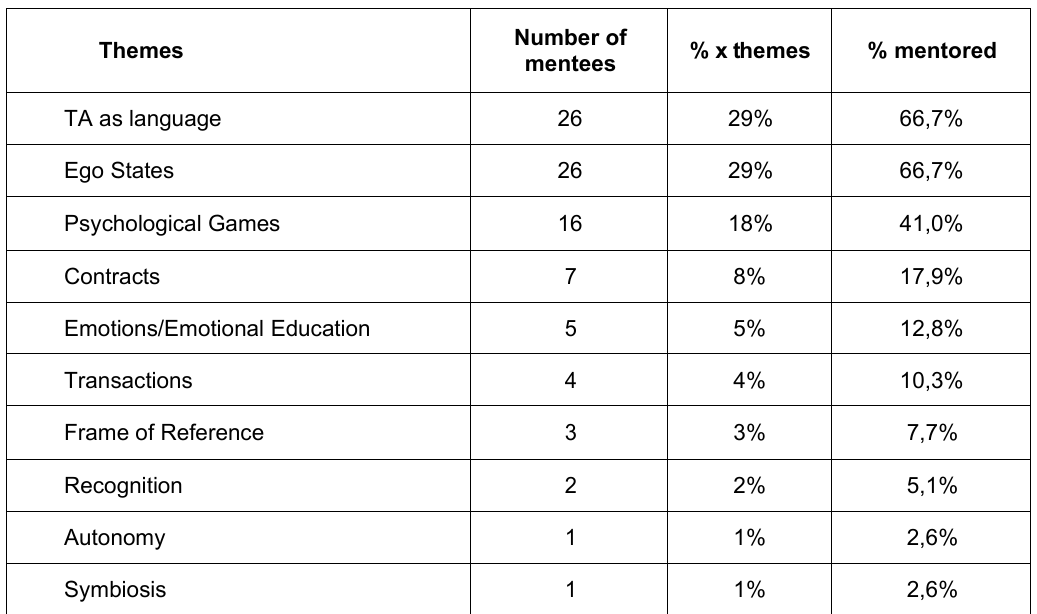
Table 1: Transactional Analysis themes highlighted in the MIR